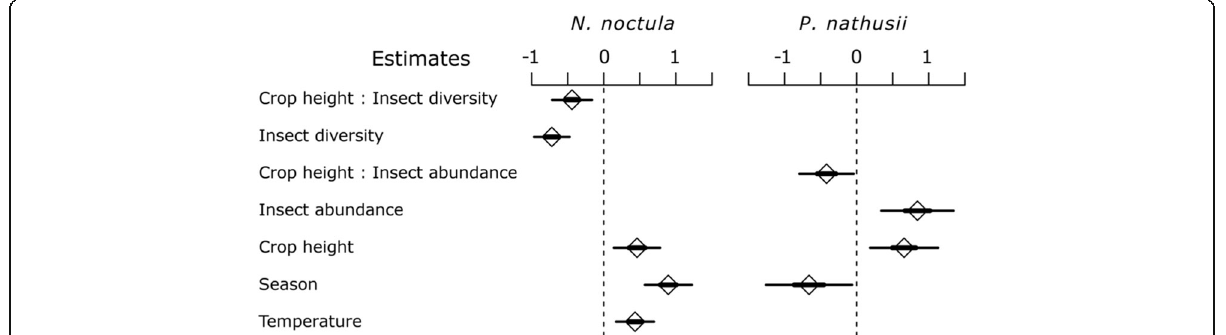
Fig. 6 Estimates of effects on the relative foraging activity of Nyctalus noctula and Pipistrellus nathusii . The foraging activity was modeled as a proportion of feeding buzz minutes and the total number of minutes with bat activity in a given night and site (logit link). Estimates were taken from the best model selected by the Akaike information criterion. Note that all variables are related to the local scale of the sampled arable field. See also Fig. 7